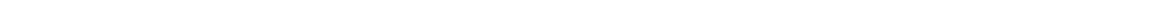
(Fig. 2f). The peak fractions were pooled and concentrated to 12.5 mg/ml using a 10 kDa Cut-off Amicon Ultra centrifugal fi lter (Millipore). All puri fi cation steps